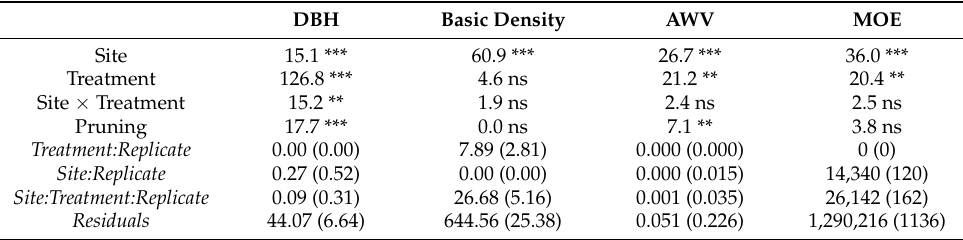
Table 3. Statistics for commercial thinning (EC300) vs. control treatment across three sites of the Eucalyptus nitens thinning trials. Results are F-tests for fixed effects and variance with standard deviation in parentheses for the random effects. Random effects are denoted in italics. Pruning was considered as a co-variate and was not included in the interaction